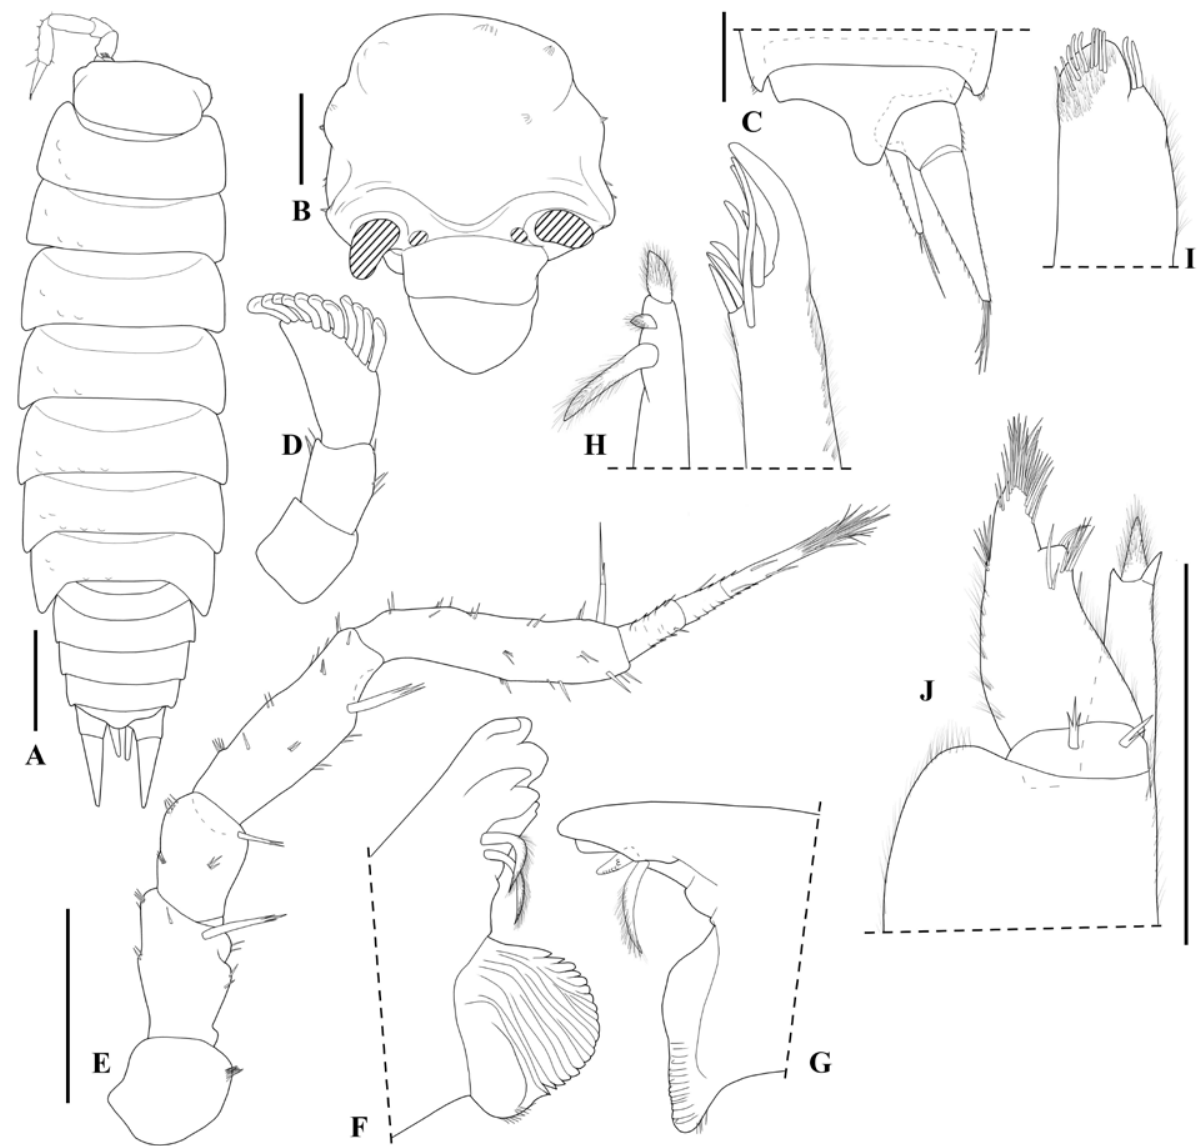
Figure 11. Pectenoniscus carinhanhensis n. sp. Male paratype: A , habitus, dorsal view; B , cephalon, frontal view; C , pleonite 5, pleotelson and uropod, dorsal view; D , antennula; E , antenna; F , left mandible; G , right mandible; H , maxillula; I , maxilla; J , maxilliped. Scale bars: A : 0,5 mm; B–J : 0.2